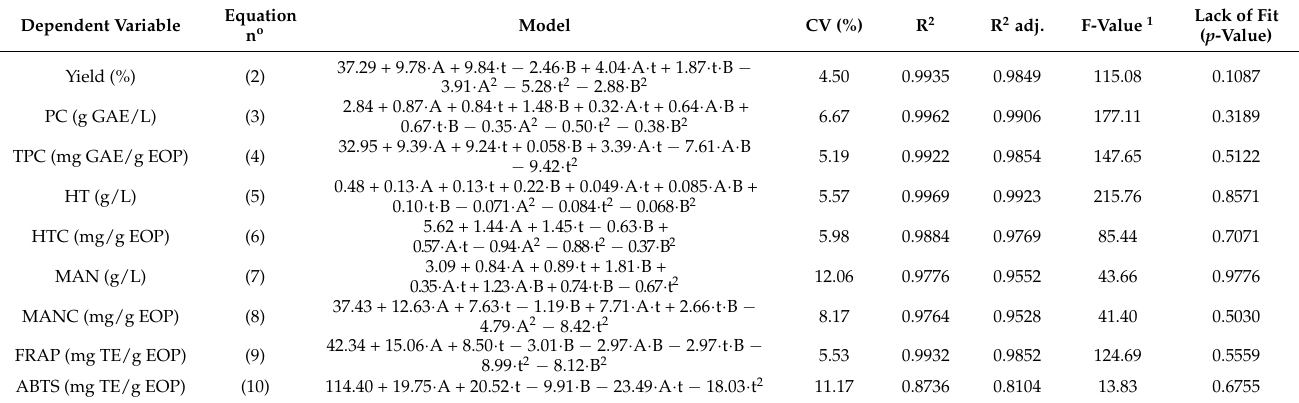
Table 3. Mathematical models and coefficients using coded values for the studied responses in the Box–Behnken experi- mental design applied to the ultrasound-assisted water extraction of exhausted olive